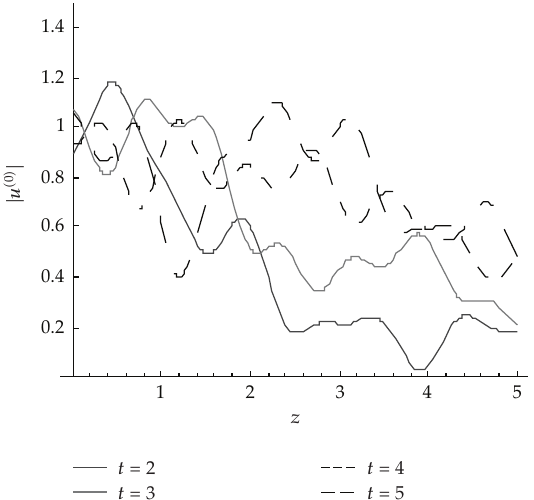
Figure 6: The zero-order approximation | u (cid:3) 0 (cid:4) | at α (cid:8) 1, T (cid:8) 10, γ (cid:8) 02 for di ff erent values of t , considering only one term in the series (cid:3) M (cid:8) 1 (cid:4) .